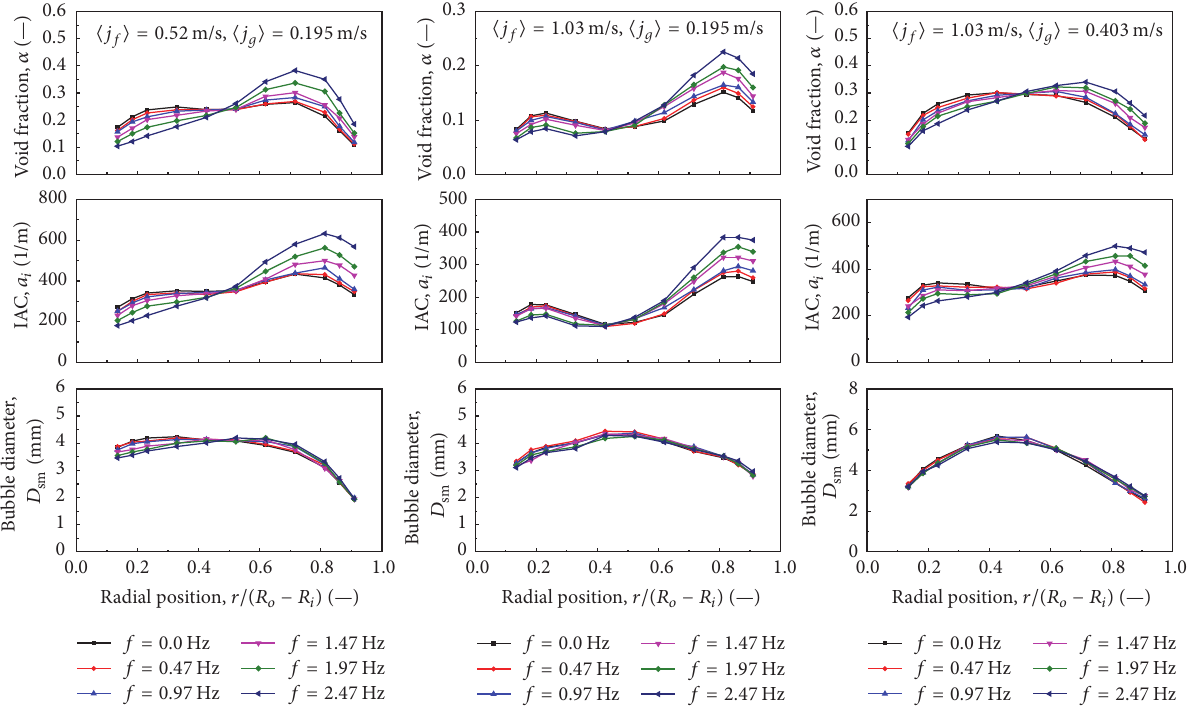
Figure 7: Vibration frequency effect on two-phase flow structure at vibration displacement of 𝑆 = 𝑆 𝑚1 .